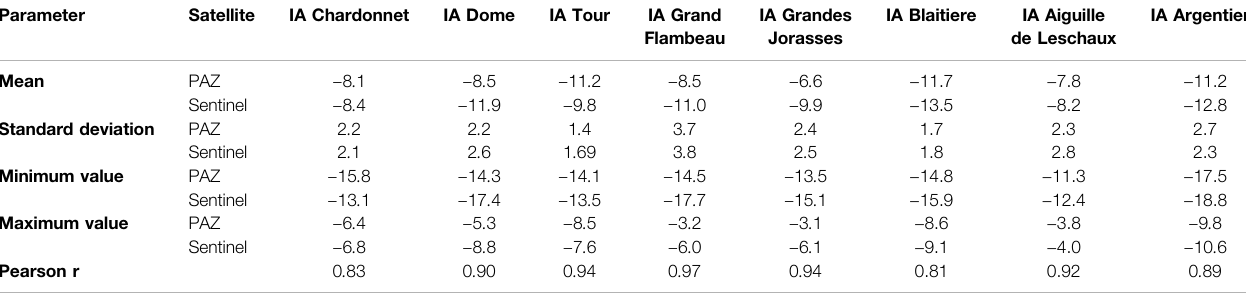
TABLE 2 | Statistical analysis of X- and C-bands RaDAR backscattering for 8 different IAs. Parameter